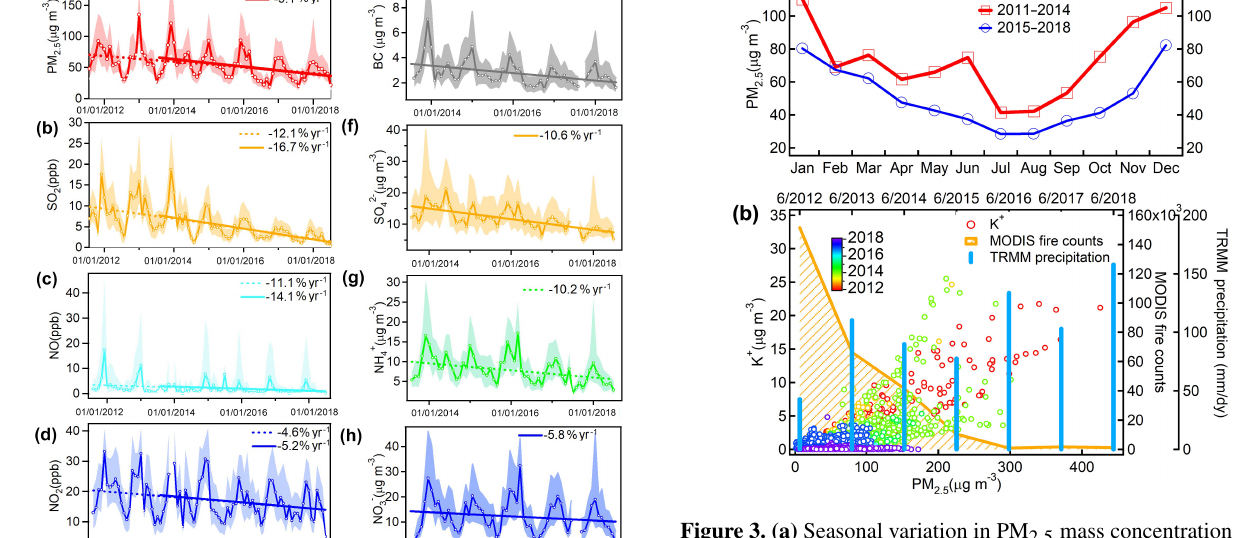
Figure 3. (a) Seasonal variation in PM 2 . 5 mass concentration mea- sured at SORPES during 2011–2014 and 2015–2018. (b) Scatter plots of K + as a function of PM 2 . 5 concentration measured at SOR- Figure 2. Monthly statistics and trends for (a) PM 2 . 5 , (b) SO 2 , (c) PES and the sum of MODIS fire counts and of TRMM precipitation NO, (d) NO 2 , (e) BC, (f) SO 2 − , (g) NH + , and (h) NO − observed in the BB domain (square in Fig. 1b) during 15 May–20 June, 2012– 4 4 3 at SORPES. Note: for BC, SO 2 − , NH + , and NO − , only data dur- 4 4 3 ing August 2013–July 2018 are shown here. The solid lines marked with open circles represent the monthly medium value, and shaded areas mark the data from 25th to 75th percentiles. Dashed and solid lines show the linear regression fitting for data during 2011–2018 and 2013–2018, respectively.